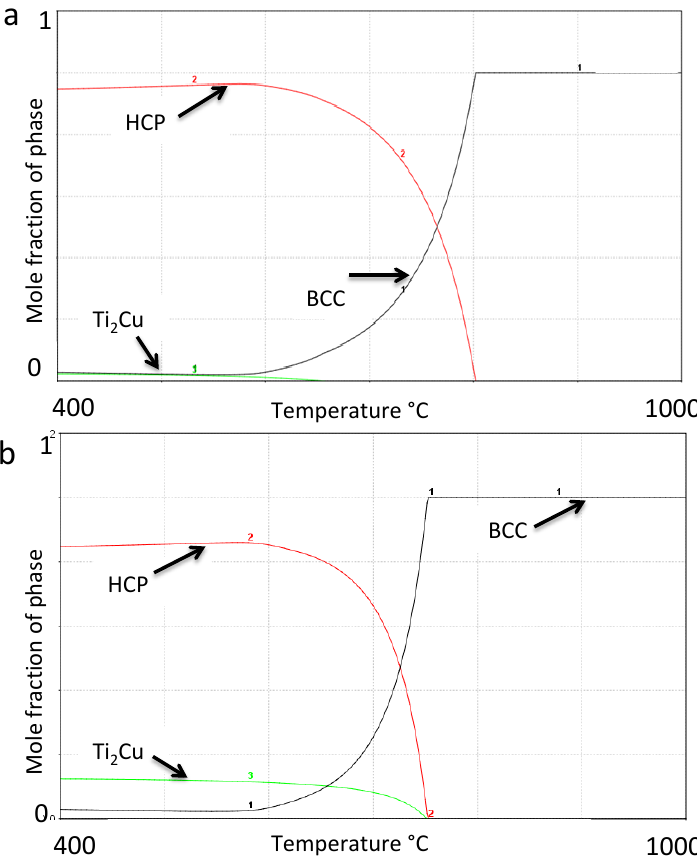
Figure 1. Mole fraction of phases as a function of temperature for ( a ) the Ti-Nb-Ta-Zr-1 wt.% Cu alloy and ( b ) the Ti-Nb-Ta-Zr-5 wt.% Cu alloy. Composition of the alloys can be found in Table 3. Table 1. Calculated β - and Ti 2 Cu-transus temperatures for the investigated alloys. Cu Addition [wt.%]